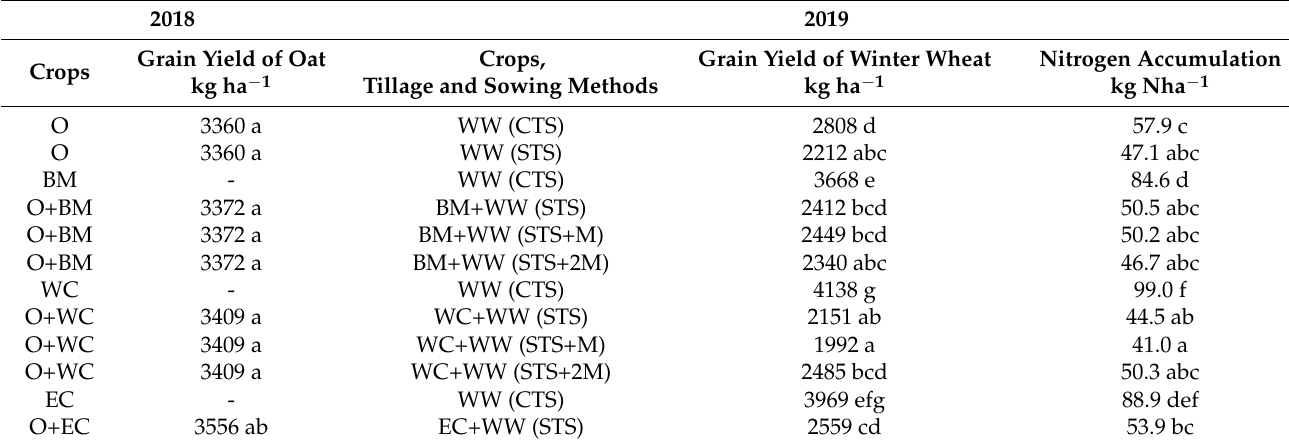
Table 2. Cereal yields in different cropping sequences using conventional and strip tillage.